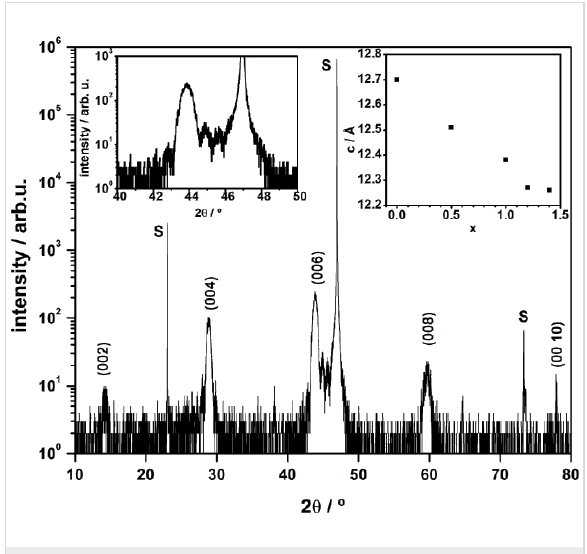
doping content. The in-plane resistivity versus temperature for La 2 − x Sr x NiO 4 with different Sr doping level is shown in Figure 8. The resistivity value systematically decreases with increasing Sr content. All the experimental data are in good agreement with those reported previously for La 2 − x Sr x NiO 4 epitaxial thin films grown by PLD [24]. Further analyses of films crystal structure, including high-resolution transmission electron microscopy (HR-TEM) and transport properties and will be presented elsewhere [25].